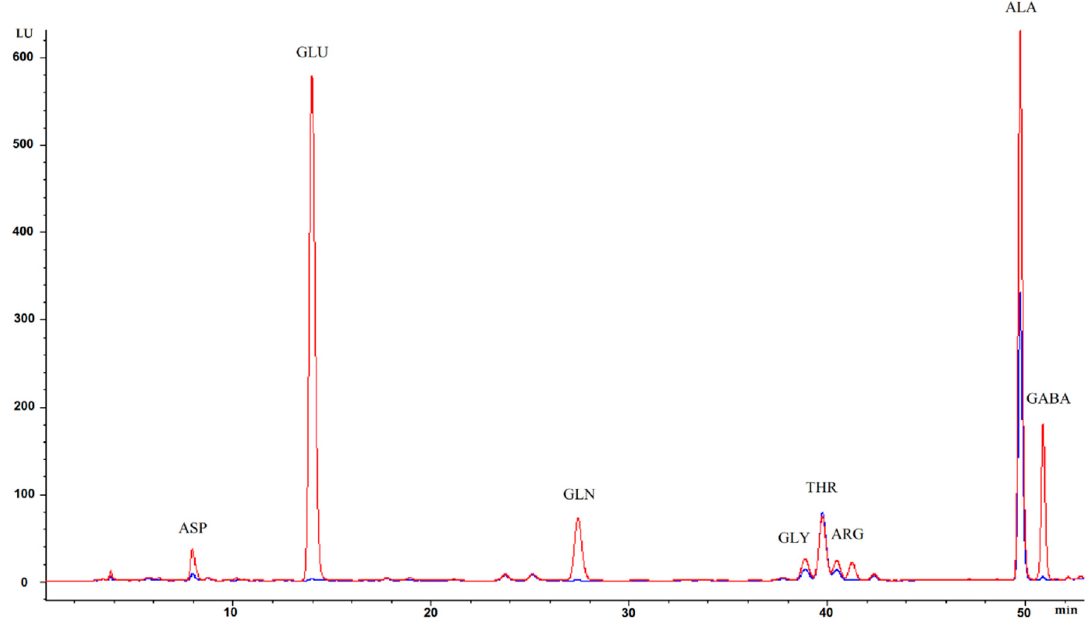
Figure 2. GABA production from L. plantarum LP 95 in LFM medium with ( ) and without ( ) L ‐ glutamic acid (GLU).